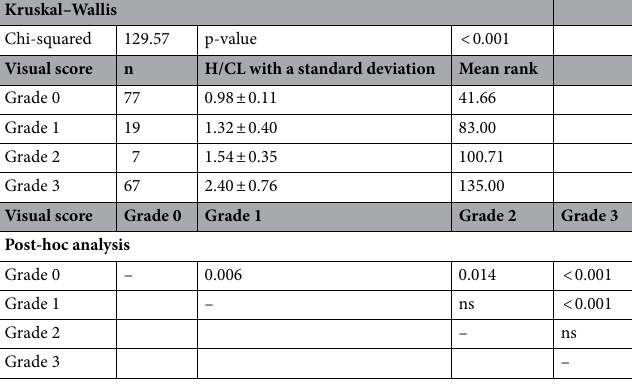
Table 1. Proposed quantitative score for the diagnosis of CA and statistical analysis. The table shows a range of values of H/CL index for each Perugini score with their respective standard deviations, with significant differences between individual distributions (p < 0.05). The Kruskal Wallis test provides significant differences between individual distributions from each Perugini visual